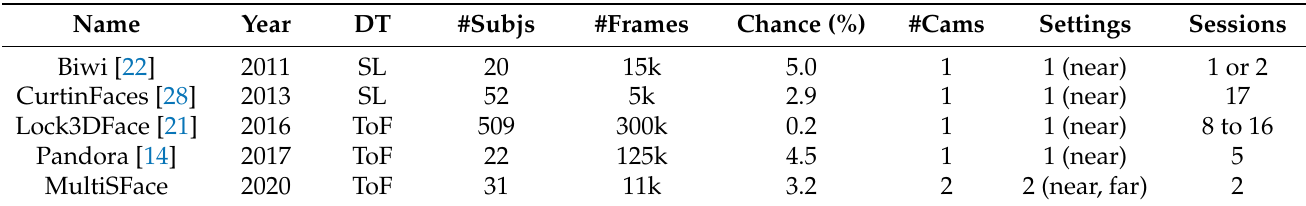
Table 1. Datasets that were selected for the proposed analysis. DT is the depth technology, #subjs is the number of subjects, #frames is the number of depth frames and #cams the number of depth camera used. The chance (level) is the accuracy with random predictions. Settings correspond to the position of the subject w.r.t. the acquisition device. Sessions is the number of different acquisitions per